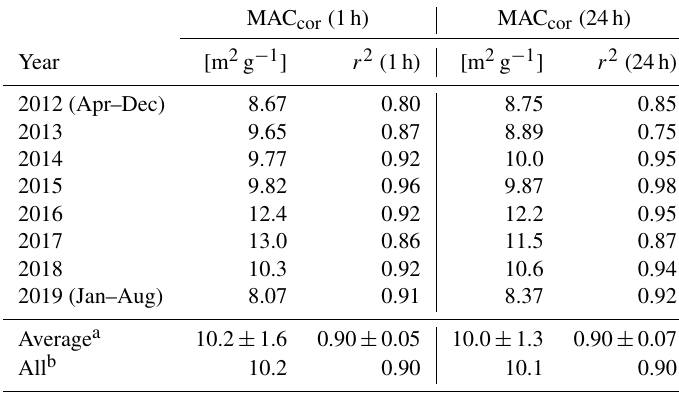
Table 7. Year-to-year variability of MAC cor (Aethalometer; λ = 590nm) and r 2 at Ny-Ålesund. MAC cor (1h) MAC cor